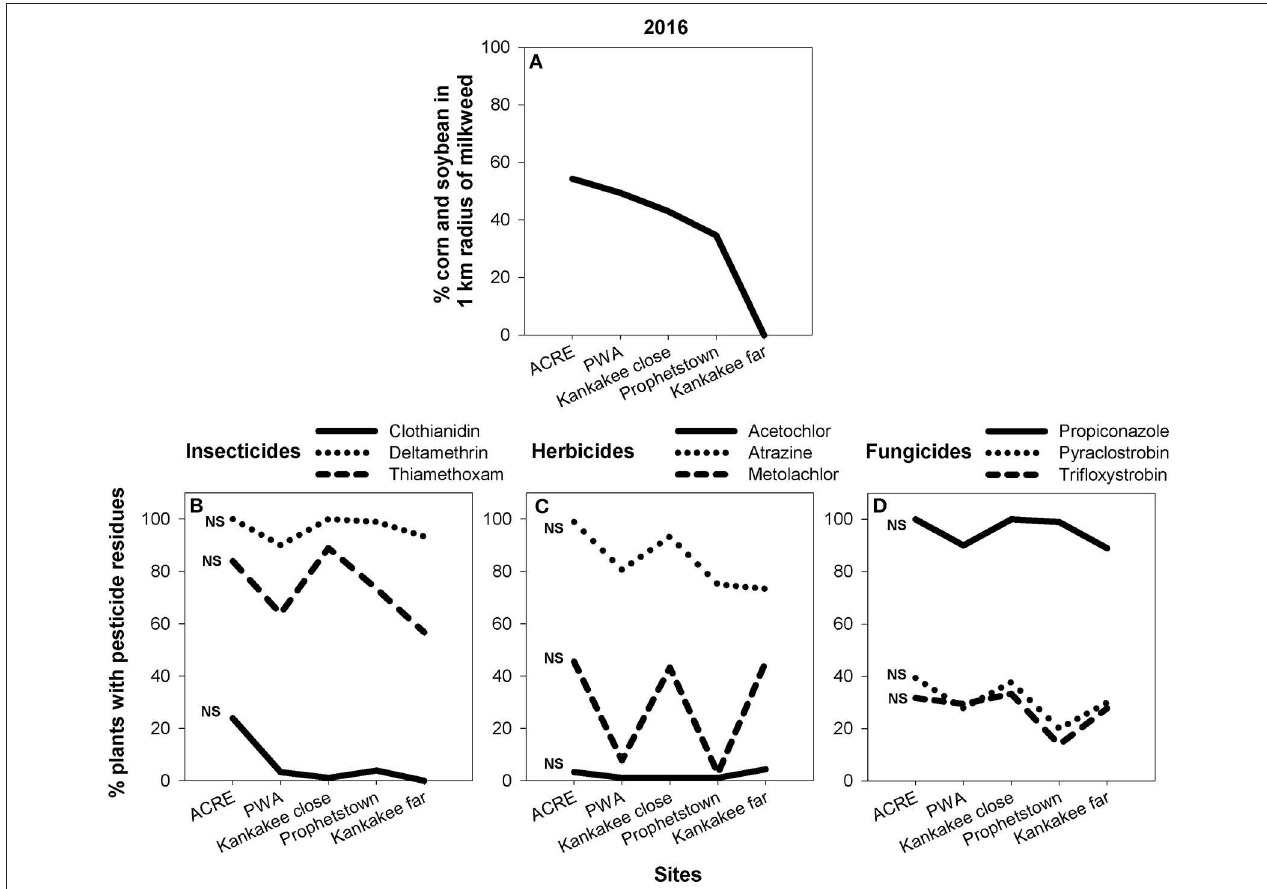
FIGURE 7 | Area of corn and soybean, expressed as percent of total land use, in 1km buffer surrounding the five milkweed sites sampled in 2016 (A) and corresponding site-level changes in insecticide (B) , herbicide (C), and fungicide (D) residues associated with milkweed leaves. Statistical analyses compare, within each pesticide, the relationship between agricultural intensification and pesticide detection frequency. ns = not significant.